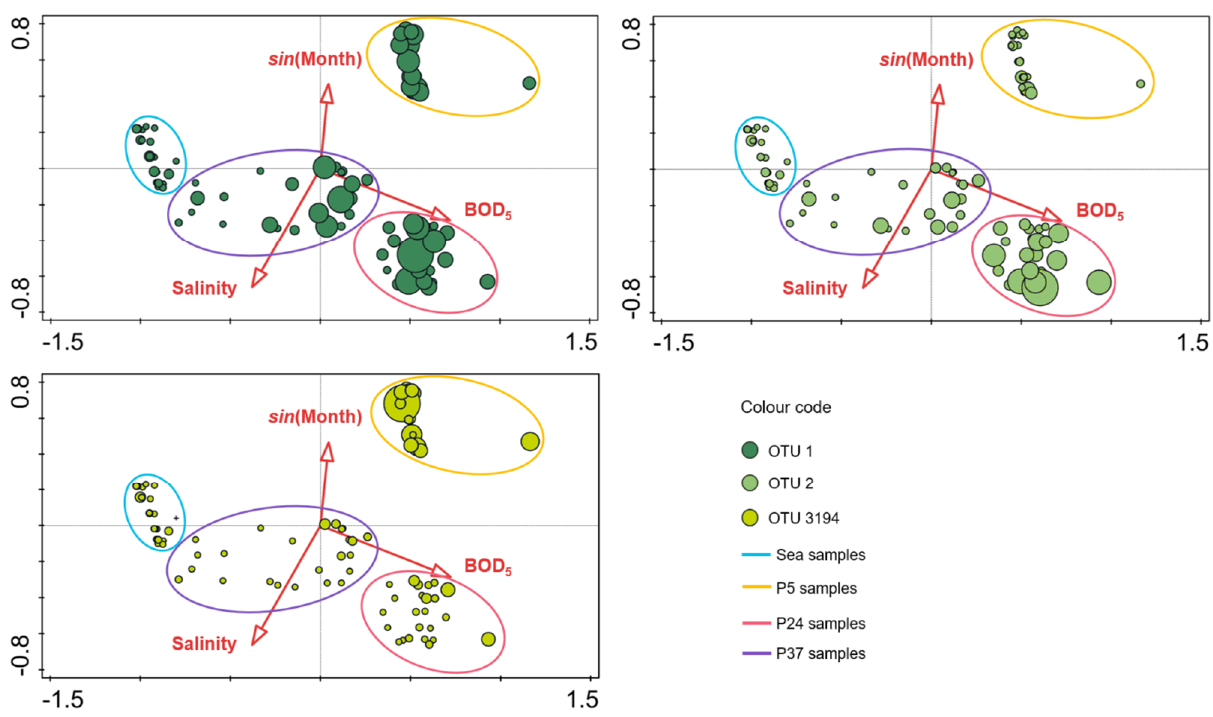
Figure 6. RDA analysis based on OTU composition of the Pontimonas communities found along the ST salinity gradient. Each triplot evidences the occurrence of one of the three most abundant OTUs. Circle size is proportional to the OTU relative abundance in the samples; OTU absence in a sample is indicated by “+”.